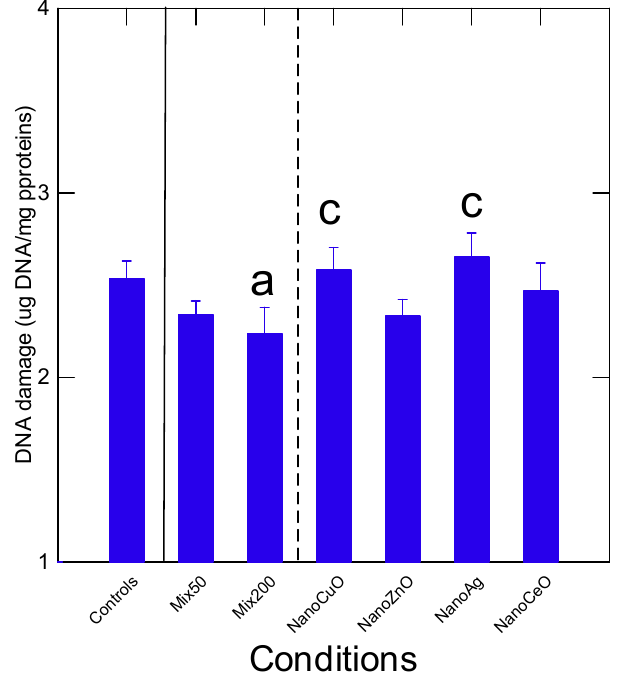
Figure 3. Analysis of DNA strand breaks in mussels exposed to the elemental nanoparticles. The levels of DNA strand breaks were determined by the alkaline DNA precipitation assay. The data represent the mean with the standard deviation. The data represent the mean with the standard deviation. The letters a denotes a significant difference to controls, the letter b significant effect from the Mix50, and c a significant difference from Mix200.